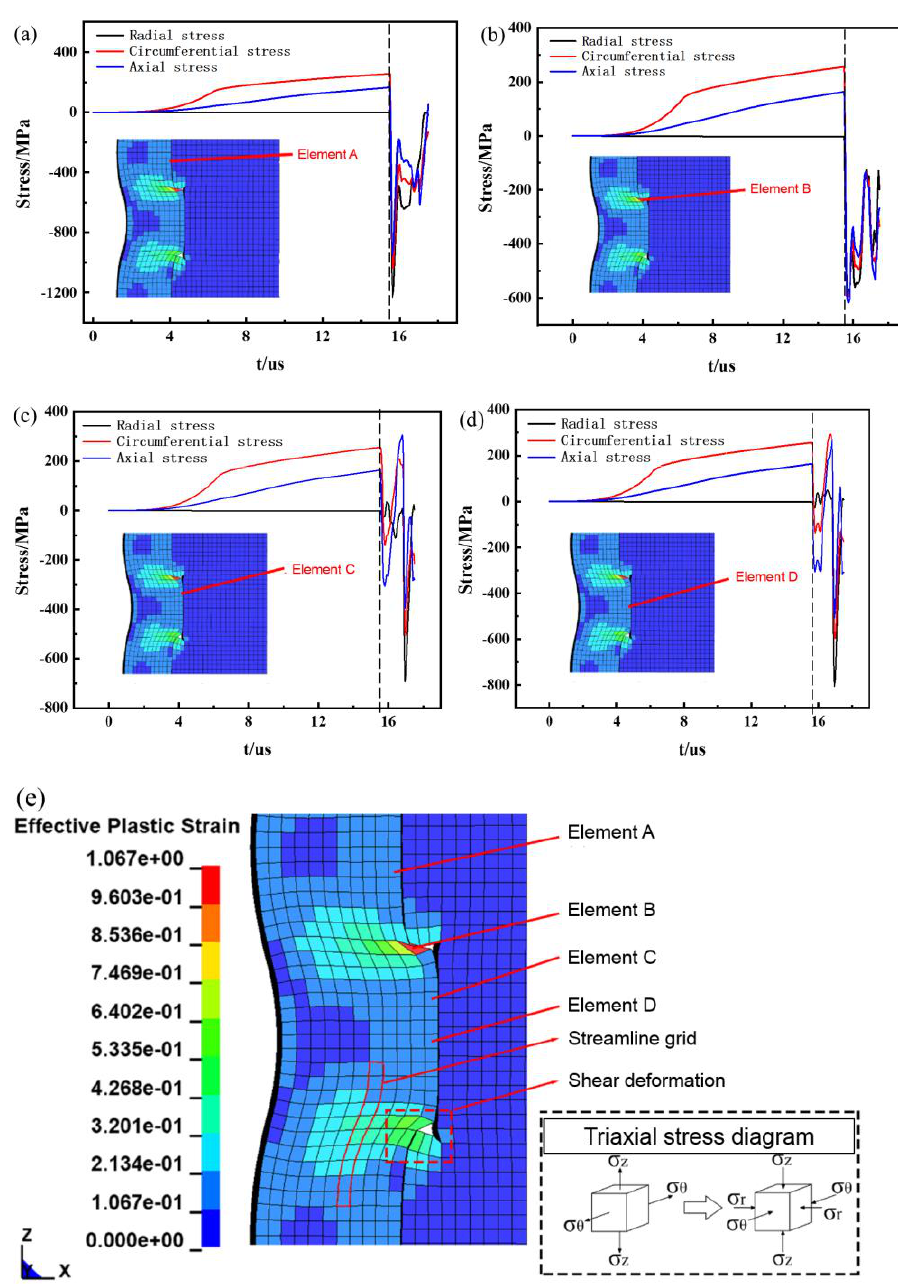
Figure 20. Analysis of stress state in deformation area of pipeline joint during forming process. ( a ) Element A stress change curve. ( b ) Element B stress change curve. ( c ) Element C stress change curve. ( d ) Element D stress change curve. ( e ) Schematic diagram of the overall stress state change.